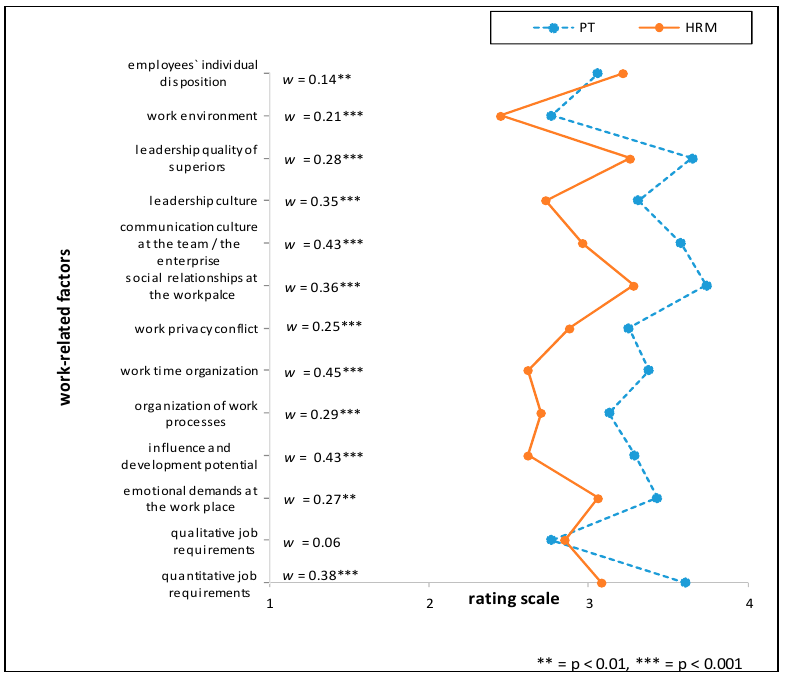
Figure 2. Polarity profile across work-related factors potentially important for (stress-associated) mental disorders in employees comparing the mean value ratings from “not at all important” (1) to “very important” (4) of Human Resource Managers (HRM) and Primary Care Physicians (PCP), w = effect size of differences.